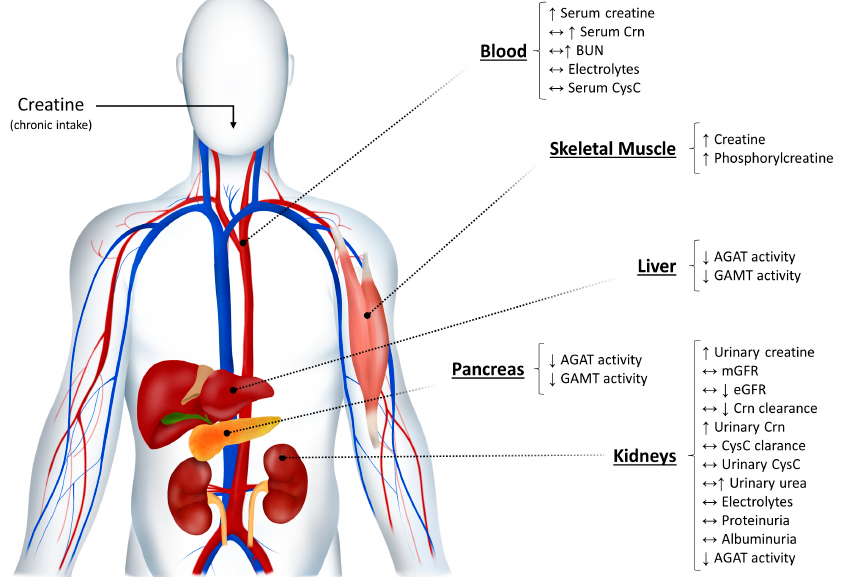
Figure 1. Effects of creatine supplementation on creatine metabolism and kidney function parameters, based on randomized controlled trials in humans [5,38,40–68]. Oral intake of creatine increases total creatine body pool (particularly in skeletal muscle), also leading to an increase (in some cases) in serum Crn from the spontaneous (i.e., non-enzymatically) and irreversible degradation of creatine into Crn, at a rate of ~2% of the total body pool per day. At the same time, AGAT activity is inhibited in the liver, pancreas, and kidneys, decreasing the formation of guanidinoacetate and the endogenous creatine biosynthesis by GAMT. In response to supplementation, creatine’s amino acid precursors could be deviated to alternative metabolic pathways (e.g., the urea cycle), potentially increasing plasma levels of blood nitrogen compounds (e.g., BUN) and its urinary excretion. Although natural fluctuations in Crn may occasionally occur due to creatine intake, kidney function remains preserved as concluded from the stable levels of several biomarkers independent of creatine metabolism (e.g., mGFR, CysC, proteinuria, albuminuria, etc.). AGAT: L-arginine:glycine amidinotransferase; BUN: blood urea nitrogen; Crn: creatinine; CysC: cystatin C; eGFR: estimated glomerular filtration rate; GAMT: guanidinoacetate methyltransferase; mGFR: measured glomerular filtration rate. Arrows indicate the direction of change of a given parameter following creatine supplementation; i.e., increased ( ↑ ), decreased ( ↓ ), and/or unchanged ( ↔